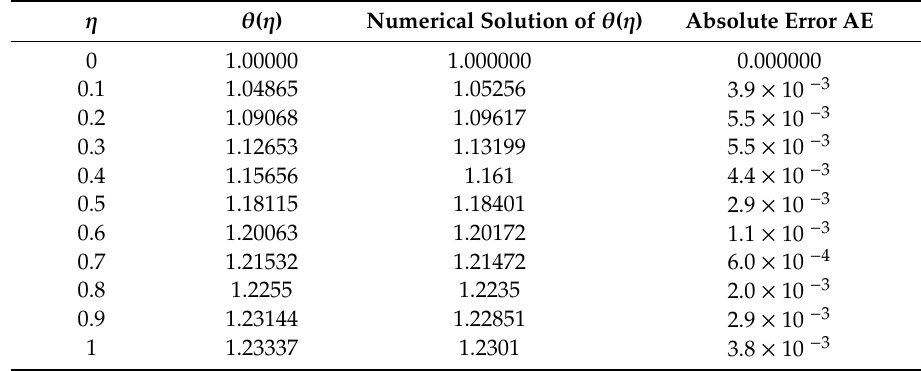
Table 4. Relationship between Homotopy Analysis Method (HAM) and ND-Solve for f ( η ) in case of n = 2, when β = ε = 1, St = M = 0.1, ξ =